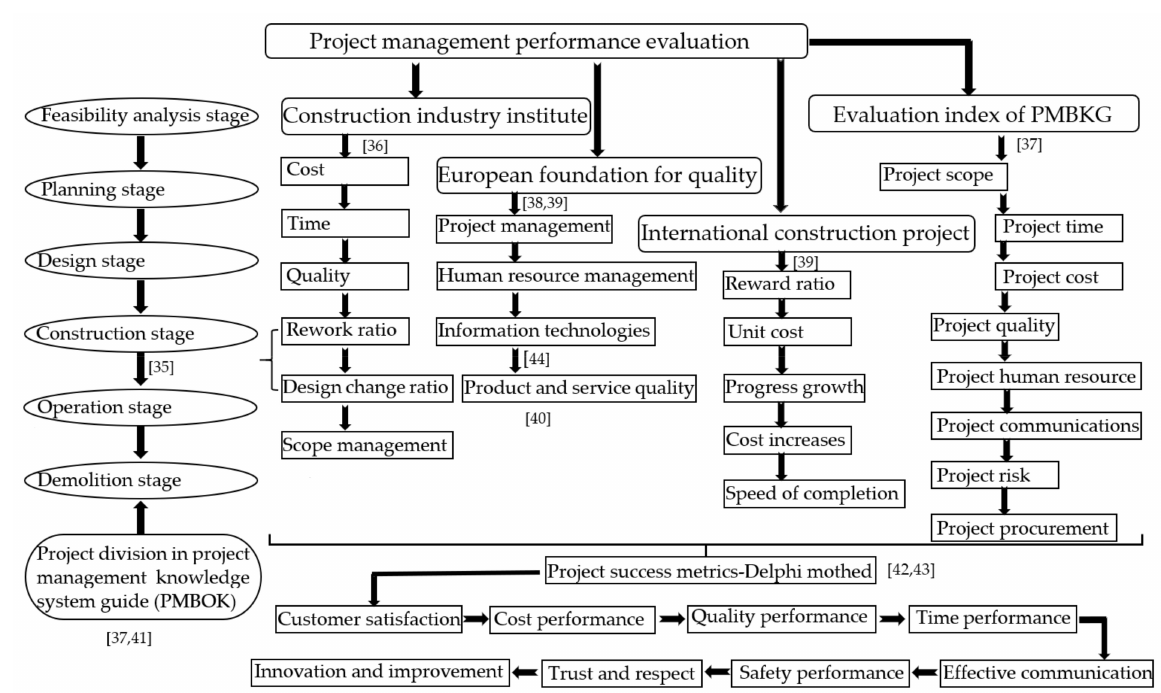
Figure 4. Four types of project management evaluation system and international project success index statistics